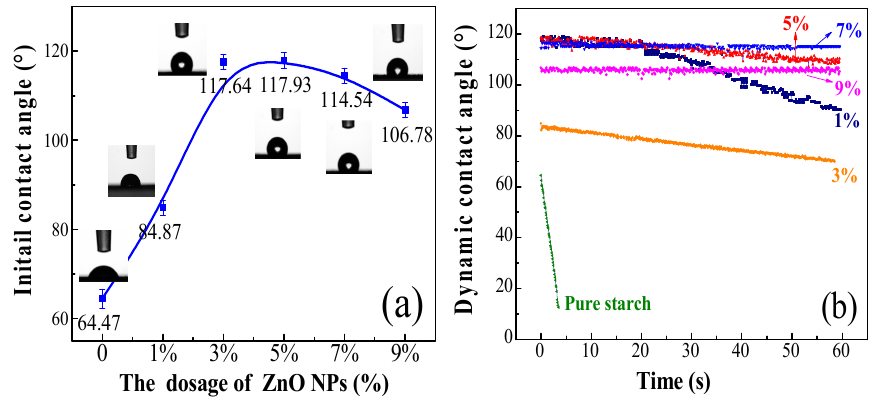
Figure 8. The water ICA ( a ) and DCA ( b ) of coated papers with different ZnO NP